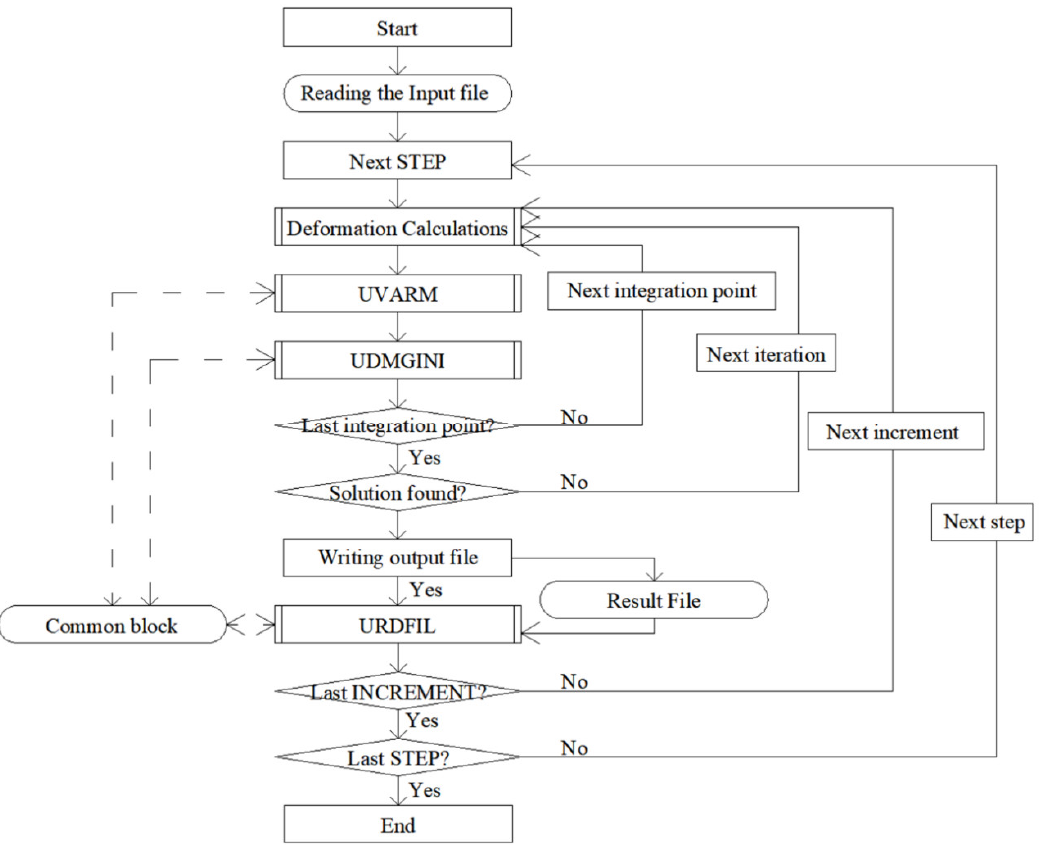
Figure 1. Simplified Abaqus finite element method (FEM) algorithm containing the necessary subroutines. Here, UVARM is the user subroutine to generate element output, UDMGINI is the user subroutine to define the damage initiation criterion and URDFIL is the user subroutine to read the results file.